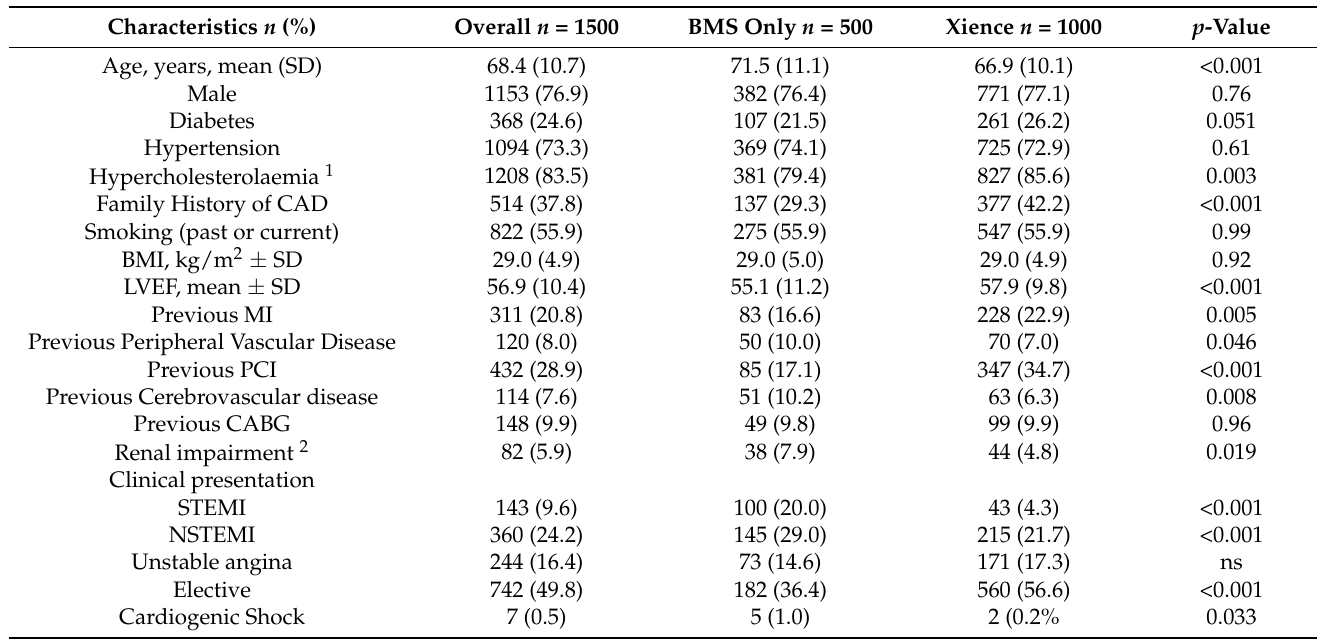
Table 1. Baseline Clinical Characteristics.